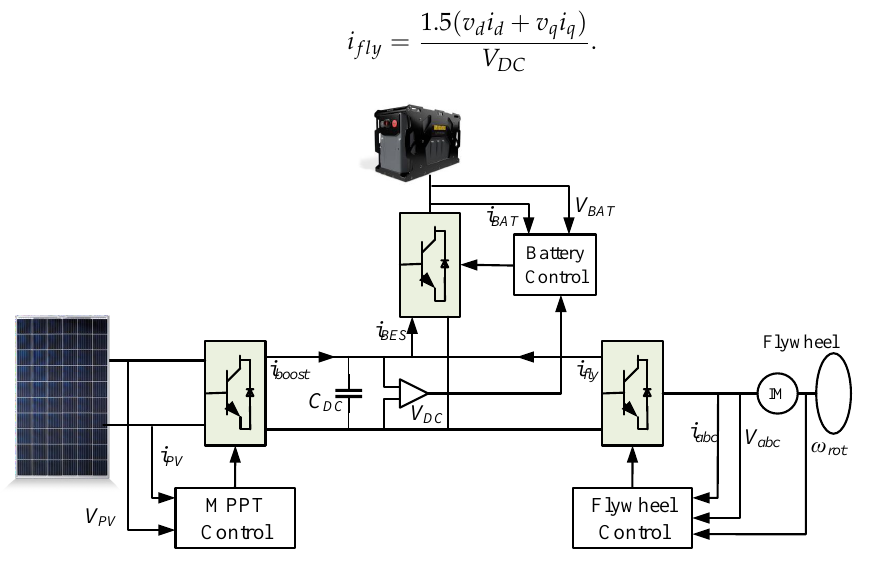
Figure 3. Flywheel storage system for fast charging station.